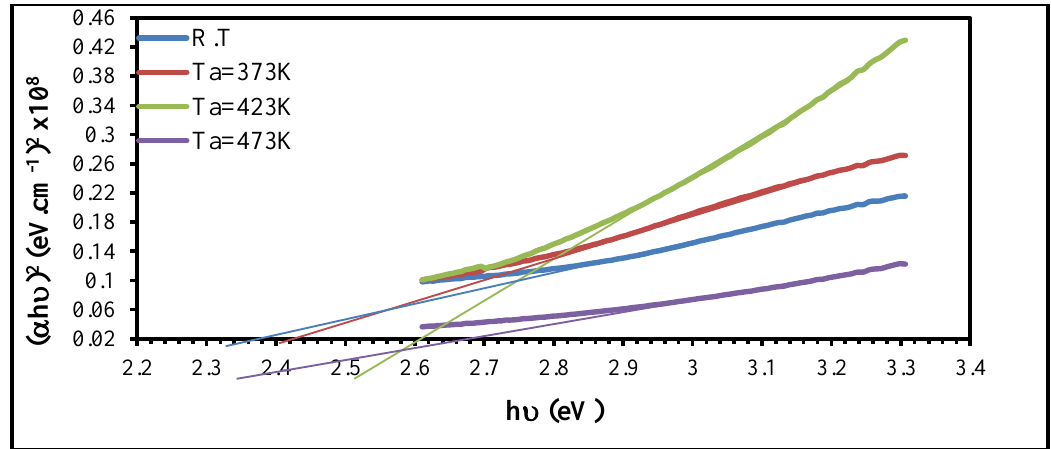
Fig. 5: (αhʋ) 2 versus photon energy of deposited and annealed Alq at different Ta.